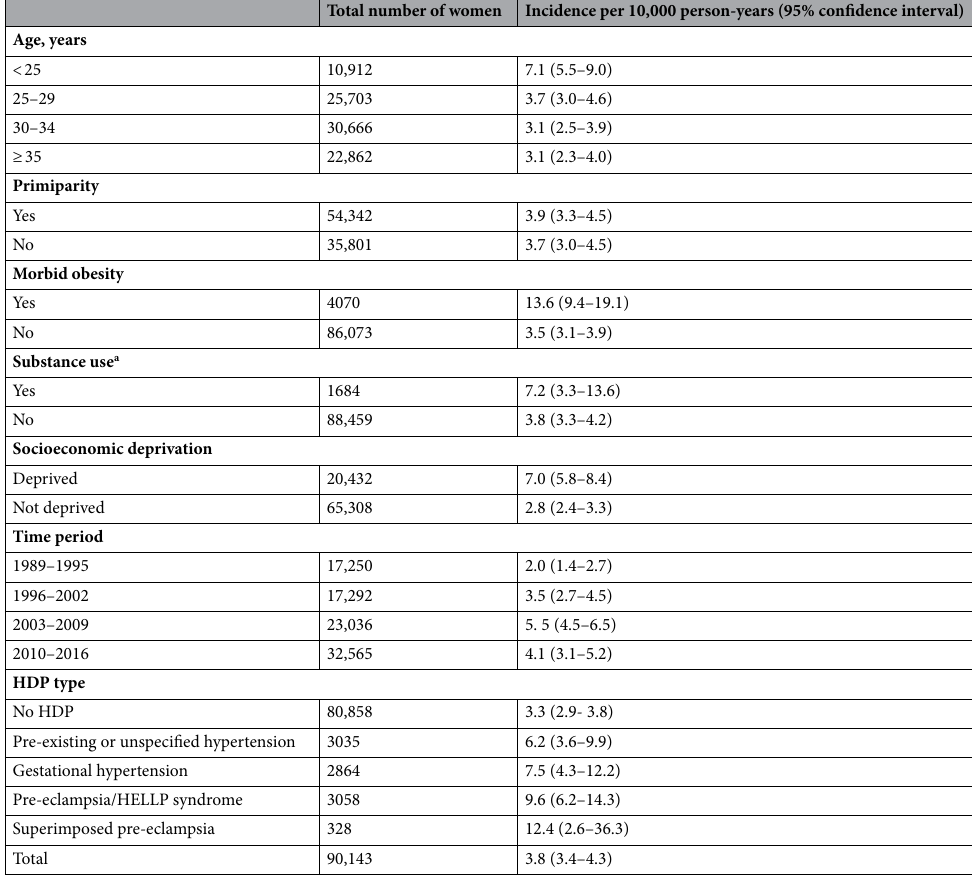
Table 1. Ten-year incidence of type 2 diabetic complications in women with gestational diabetes mellitus, according to characteristics at cohort entry. a Tobacco, alcohol, or drug (cocaine, opioids, stimulants, hallucinogens, sedatives, hypnotics, volatile solvents) use